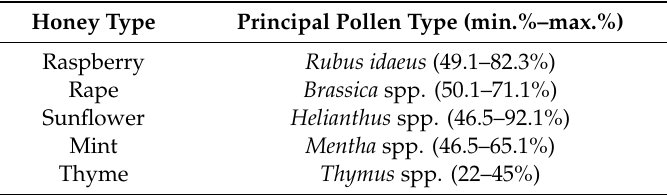
Table 1. Pollen types in honey